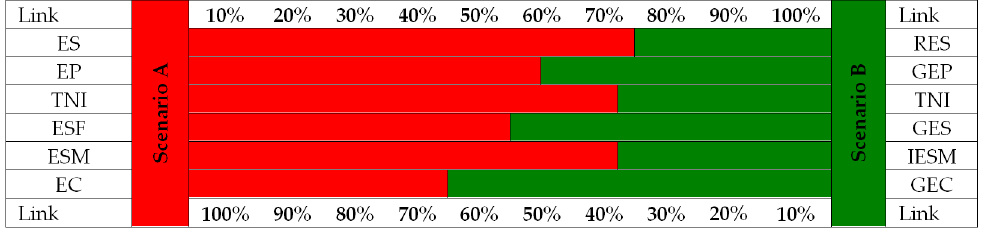
Table 4. Distribution of expert opinions.